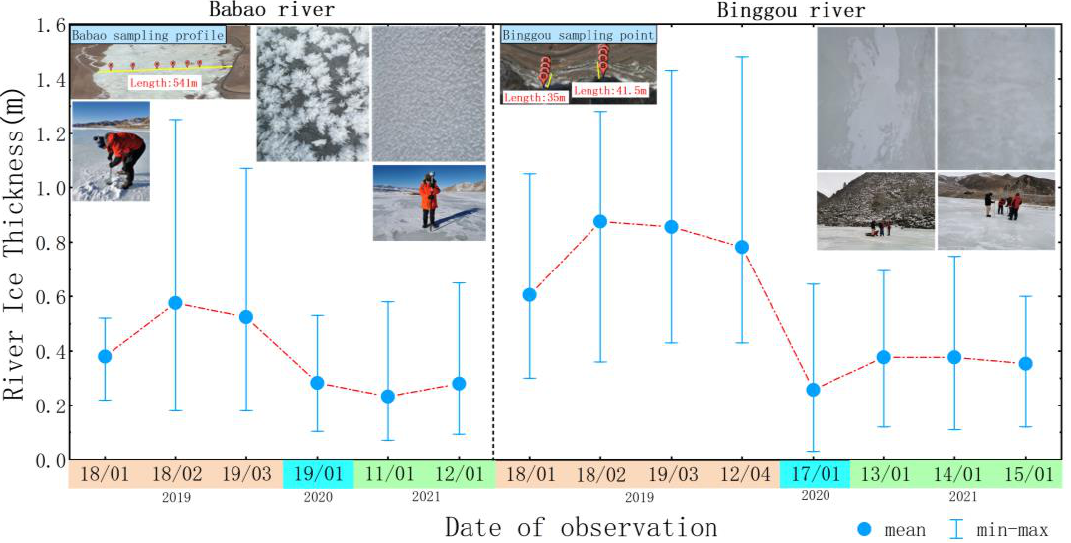
Figure 2. Daily average intervals of the measured river ice thicknesses during 2019–2021. The black dashed line indicates the dividing line between the Babao River and the Binggou River; for the horizontal coordinates, orange indicates 2019, fluorescent blue indicates 2020, and green indicates 2021.